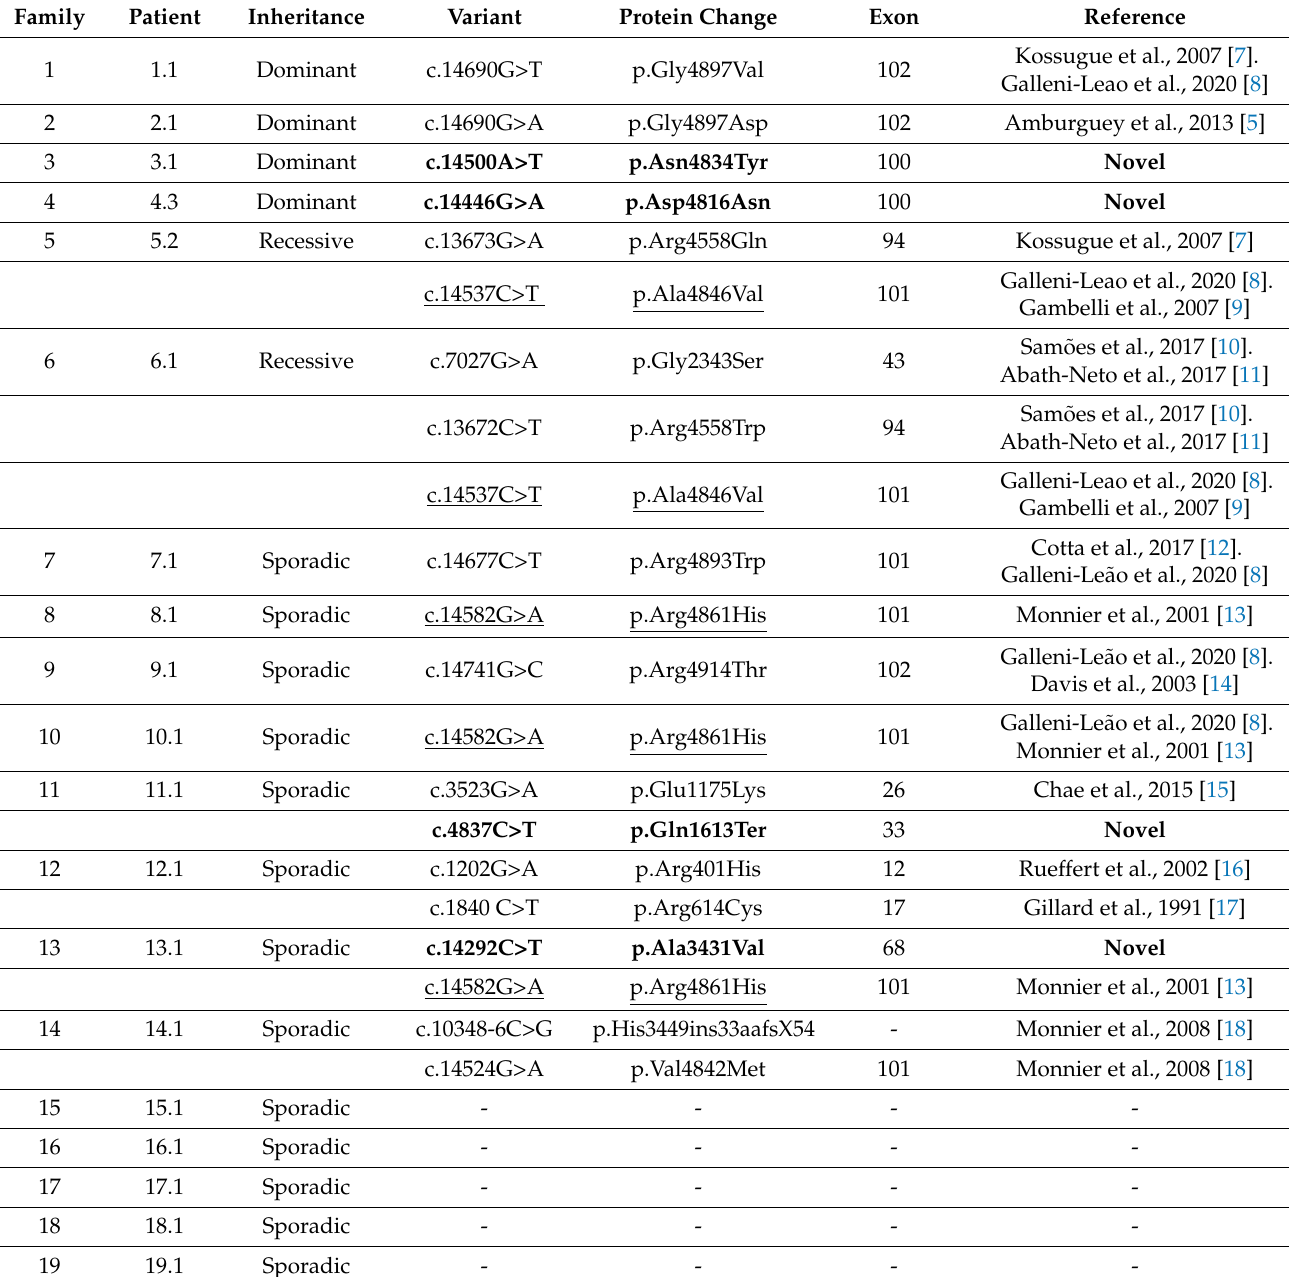
Table 3. RYR1 variants in Central Core Disease